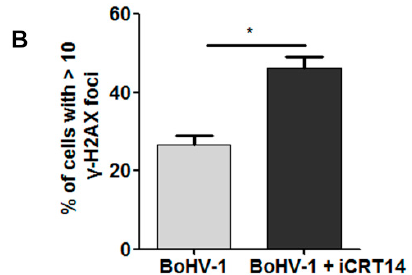
Figure 6. Effects of iCRT14 on BoHV-1-induced formation of γ H2AX foci. ( A ) A549 cells infected with BoHV-1 (MOI = 0.1) were either mock-treated with vehicle DMSO or treated with 10 µ M of iCRT14. After infection for 24 h, the cells were fixed with 4% formaldehyde, and the formation of γ H2AX foci was detected by IFA. Nuclei were stained with DAPI. Images were obtained by confocal microscopy (magnification × 600 with 2.5 zoom). ( B ) The percentage of cells having ≥ 10 foci within an individual cell was calculated. The error bars denote the variability between the three independent experiments. Significance was assessed with Student’s t -test (* p < 0.05).